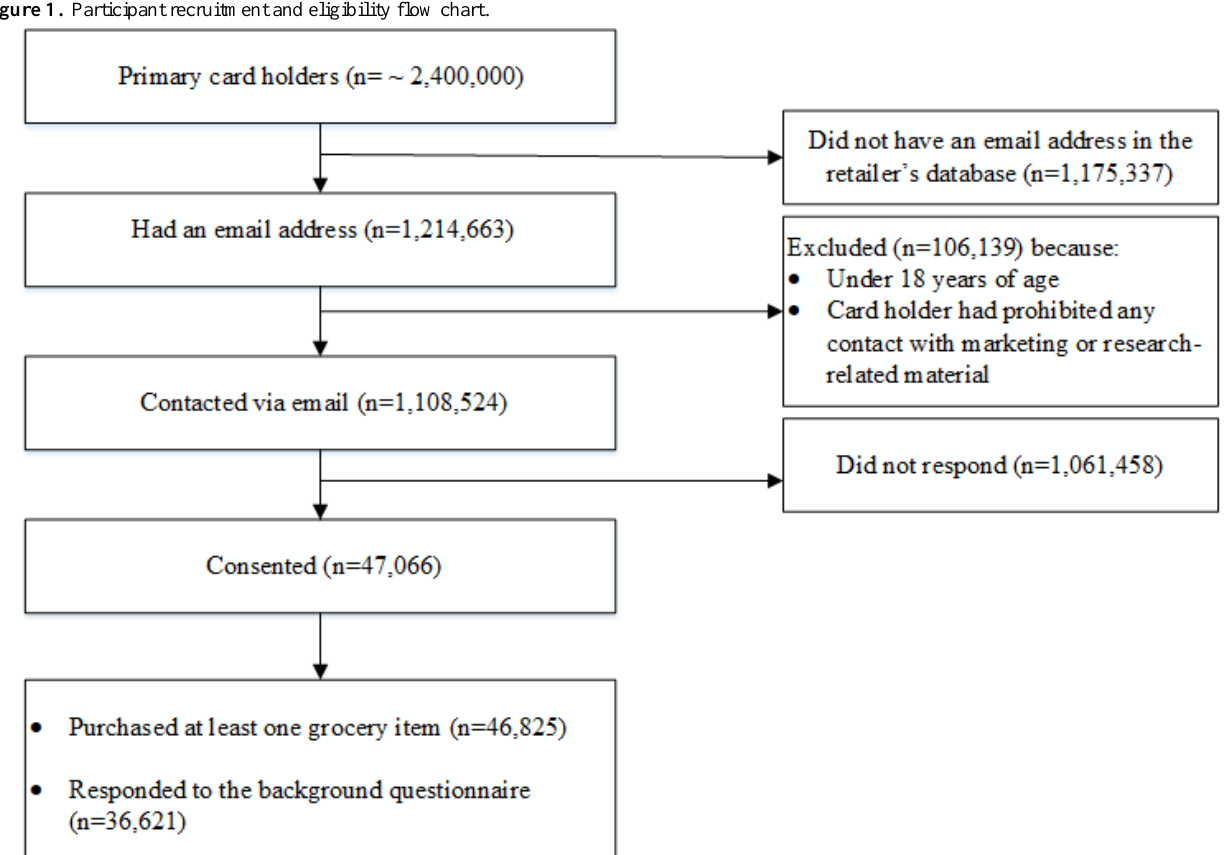
Figure 1. Participant recruitment and eligibility flow